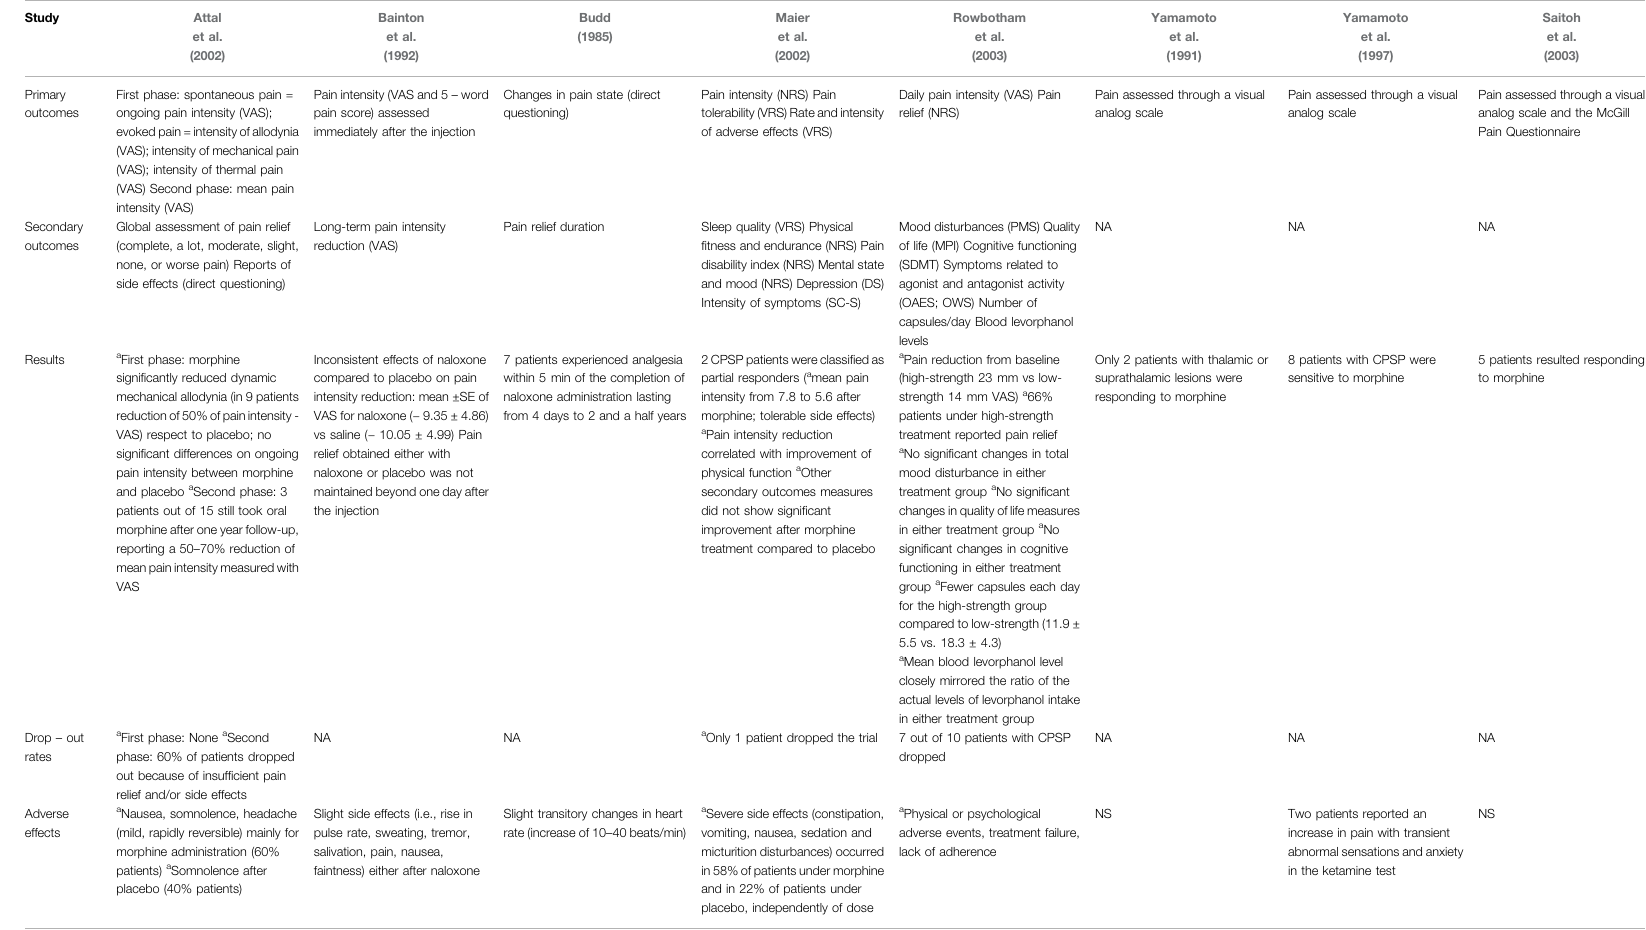
TABLE 2 | Summary of the fi ndings of the studies included in qualitative analysis.